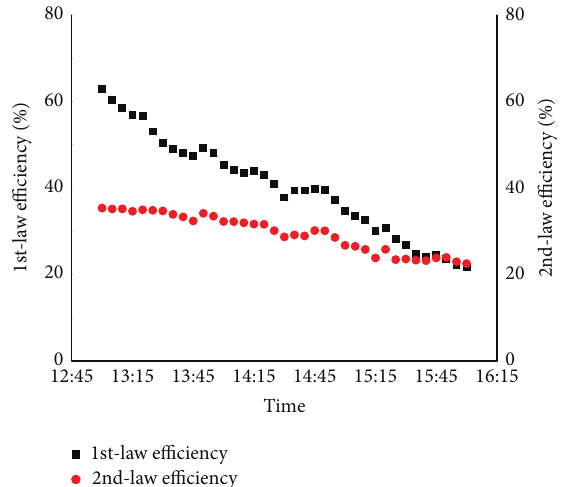
Figure 13: Variation of overall efficiency of the HCPV/T